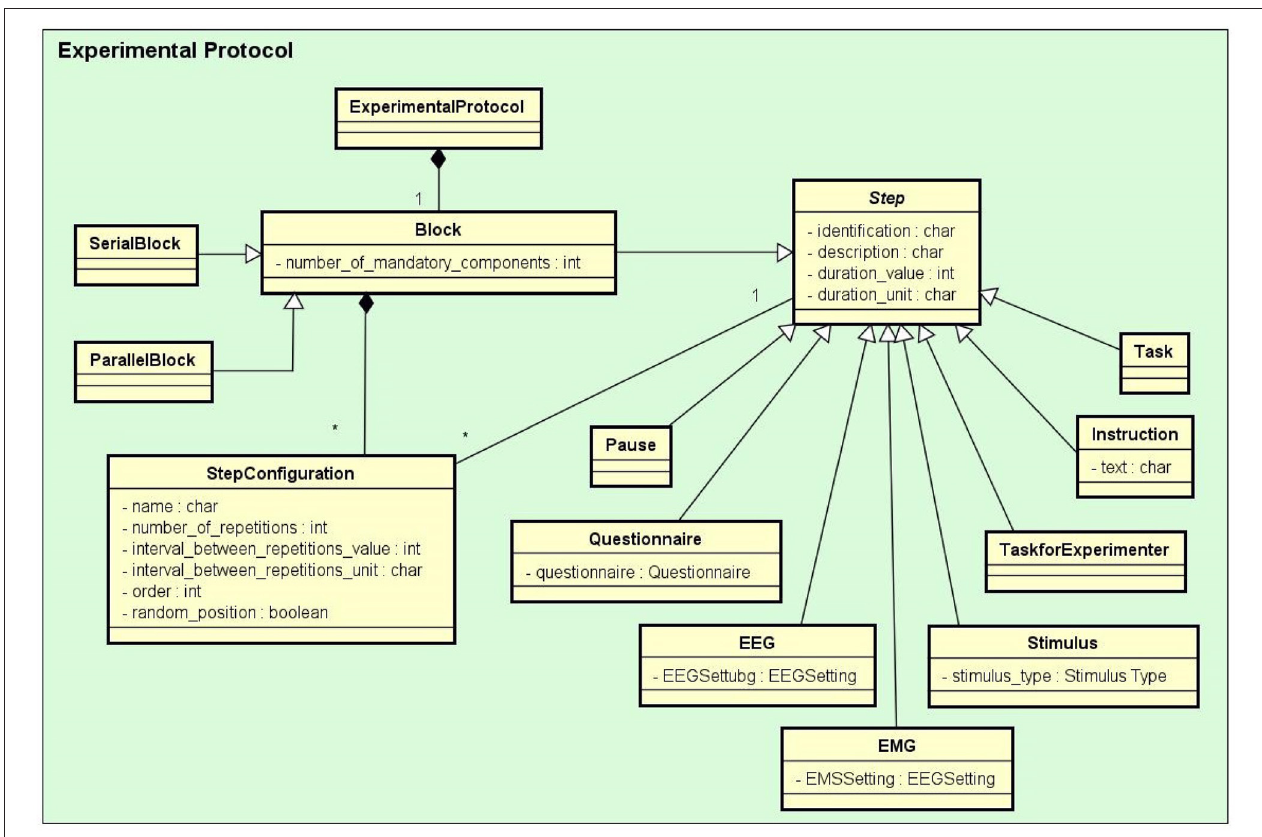
FIGURE 2 | The Experimental Protocol conceptual data schema. In the diagram, the rectangles represent entity types and some of their main attributes, the lines ending with black diamonds represent composition relationships, and the lines ending with triangles represent inheritance relationships. For example: Stimulus , Task , Questionnaire , and EEG are subtypes of Step , each one of them inherits the properties of Step . An ExperimentalProtocol is composed of a Block (of blocks) of StepConfigurations which define how the protocol Steps are